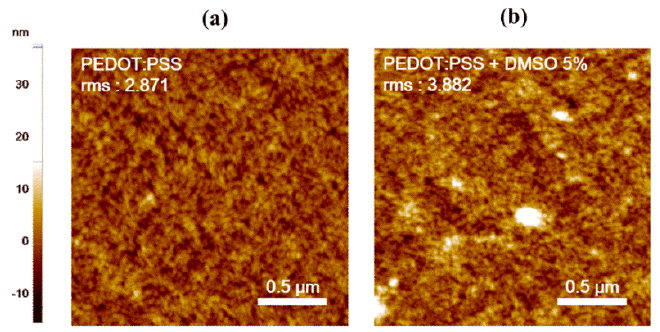
Figure 2. AFM images of PEDOT:PSS films: ( a ) pristine PEDOT:PSS and ( b ) PEDOT:PSS with DMSO. The surface roughness of the PEDOT:PSS films, treated with and without DMSO, was approximately 3.882 and 2.871 root-mean-square (rms), respectively. Next, the bare CPW was treated with oxygen plasma for 3 min to enhance the hydrophilicity of the surface. After that, a PEDOT:PSS solution doped with DMSO was sprayed, as shown in Figure 3a.